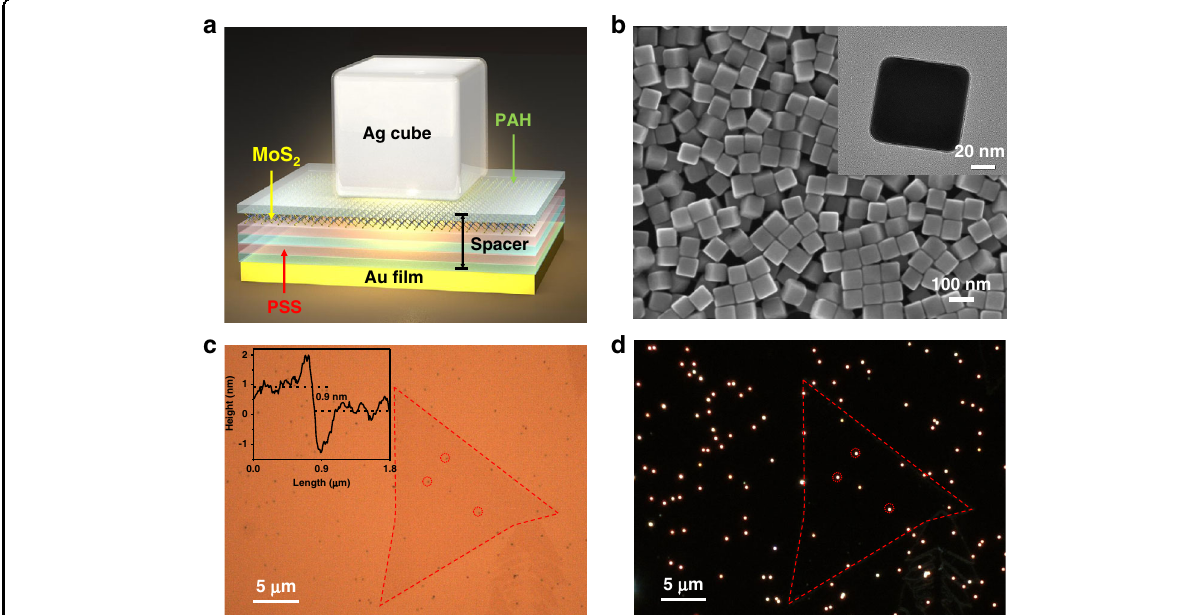
Fig. 1 The characterization of gap-mode plasmonic nanocavity. a The schematic diagram of the gap-mode nanocavity, which consists of a Au fi lm, a Ag nanocube, a monolayer MoS 2 , and PE spacer layers. b Scanning electron microscope (SEM) image of Ag nanocubes with 80 ± 3 nm (scale bar 100 nm). The inset is a transmission electron microscope (TEM) image of an Ag nanocube(scale bar 20 nm). c Bright- fi eld image and d the corresponding dark- fi eld scattering image of monolayer MoS 2 with gap-mode nanocavities (scale bar 5 μ m). The inset is the AFM height pro fi le of monolayer MoS 2 on PE-coated Au fi